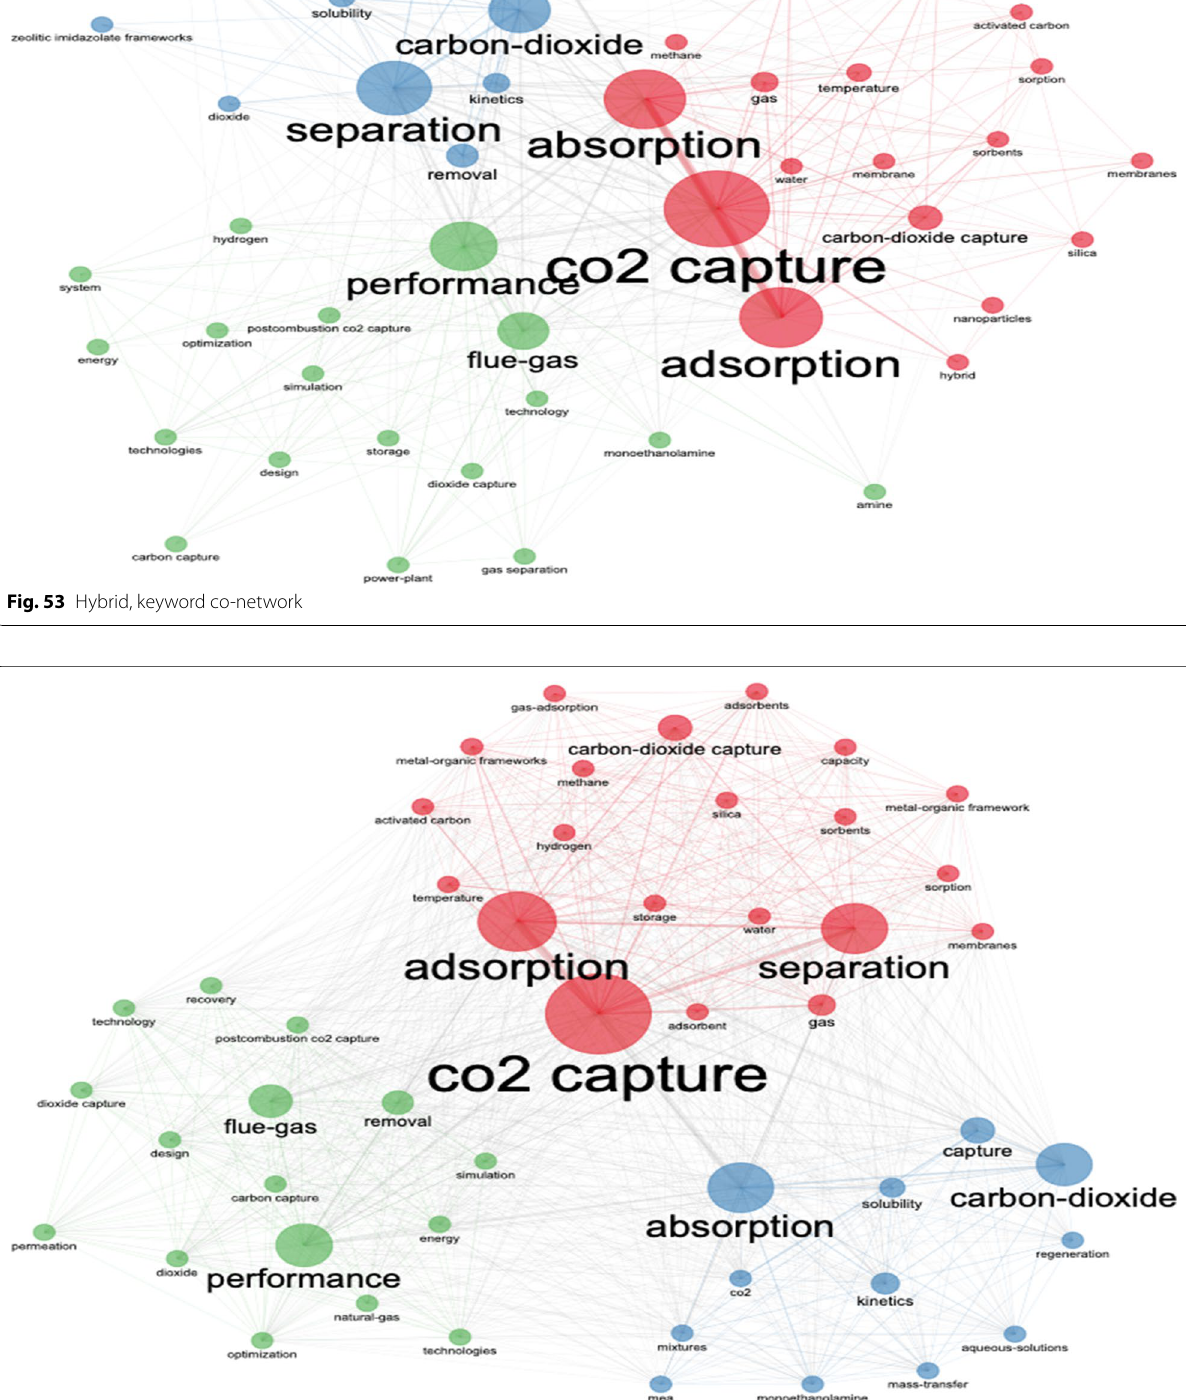
Fig. 54 Combined, keyword